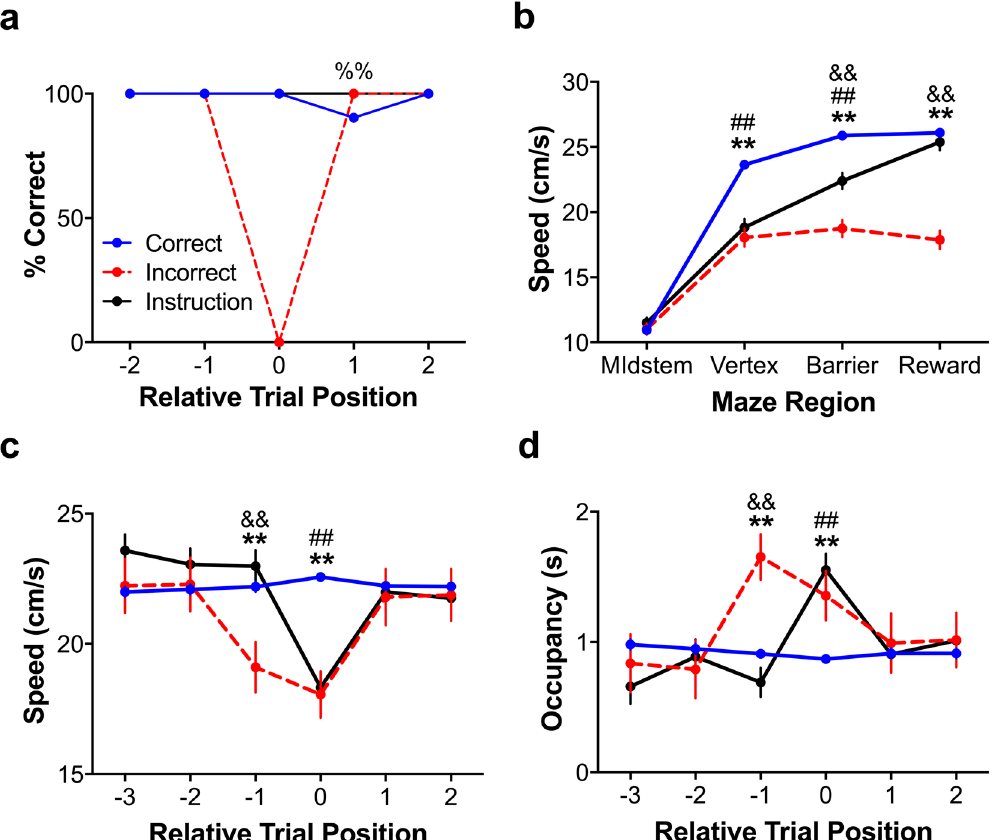
Figure 2. Maze region and trial type dependent changes in behaviour. See also Fig. S1. ( a ) Percent correct (reinforced) decisions relative to each trial type. Animals never repeated an error, indicating post-error adaptation. ( b ) Linearized running speeds by trial type and maze region. The rats ran fastest through the vertex region when making a correct choice and were slowest in implementing their decision during incorrect choice trials. The running speed gathered from the more conservative definition of the vertex region, as described in the main text, is presented here. ( c ) Vertex running speeds relative to each trial type. During post-error trials, animals’ running speeds were not different from trials following a correct choice, indicating that the animals adapted their decision behaviour following an error. Rats ran slower on the trial immediately prior to an error trial, perhaps because they ran back and forth through the vertex region in uncertainty. ( d ) Vertex occupancy relative to each trial type. Animals spent more time in the vertex during incorrect and forced trials as well as during the putative ‘lookback’ events during trials immediately prior to making an incorrect (unrewarded) choice. These data from phase A1 are presented as mean ± SEM although they were analyzed as residuals (see Methods). %% Indicates p < 0.005 via Fisher’s Exact Test; ** Indicates that correct choices were significantly different from incorrect choices at the p < 0.005 significance level via multiple comparisons tests; && Indicates that incorrect and instruction trials were significantly different at the p < 0.005 significance level via multiple comparisons tests; ## Indicates that correct choices and instruction trials were significantly different at the p < 0.005 significance level via multiple comparisons